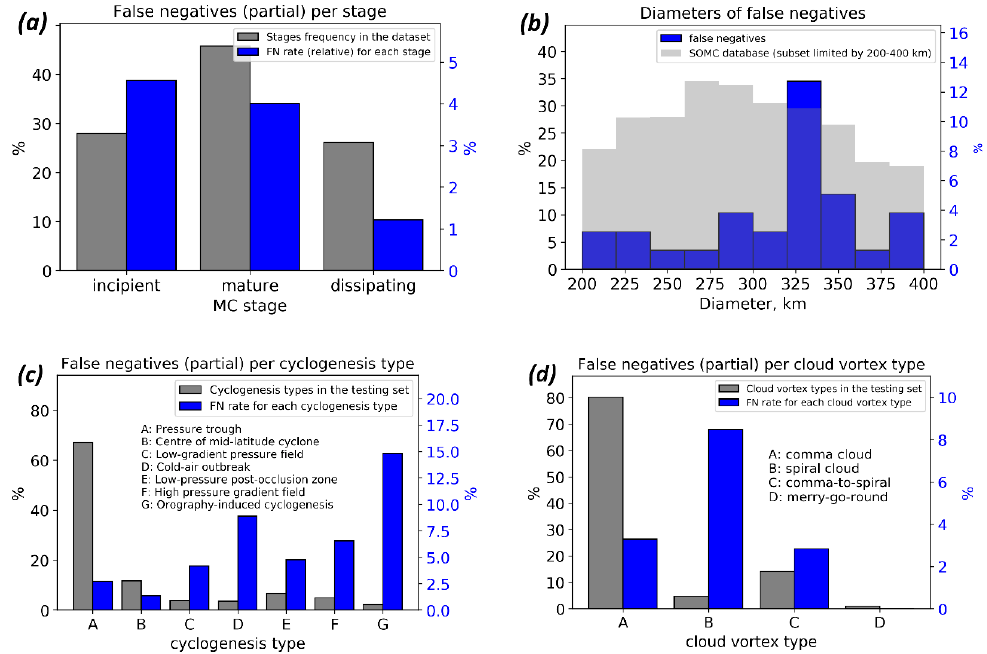
Figure 7. False negatives (FN, which are missed MCs) in the never-seen by the model testing set with respect to ( a ) lifecycle stages; ( b ) diameters; ( c ) cyclogenesis types; and, ( d ) types of cloud vortex.